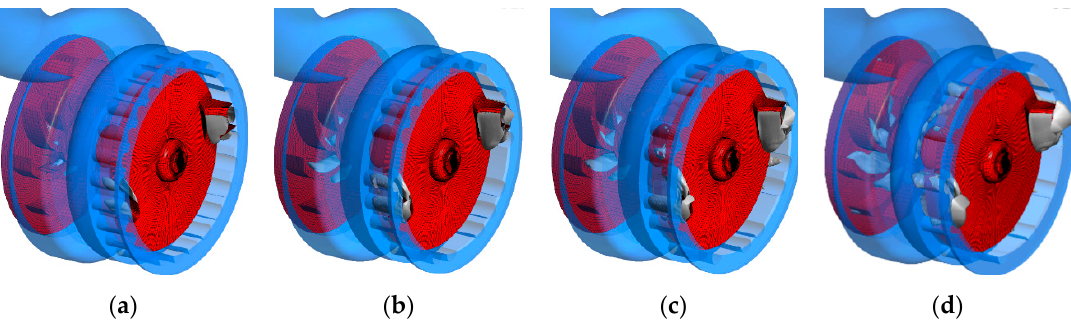
Figure 2. Cavitation distribution inside a grinder pump at different degrees of blockage [5]. ( a ) Non Clogging, ( b ) 1/4 Clogging, ( c ) 1/3 Clogging, ( d ) 1/2 Clogging.